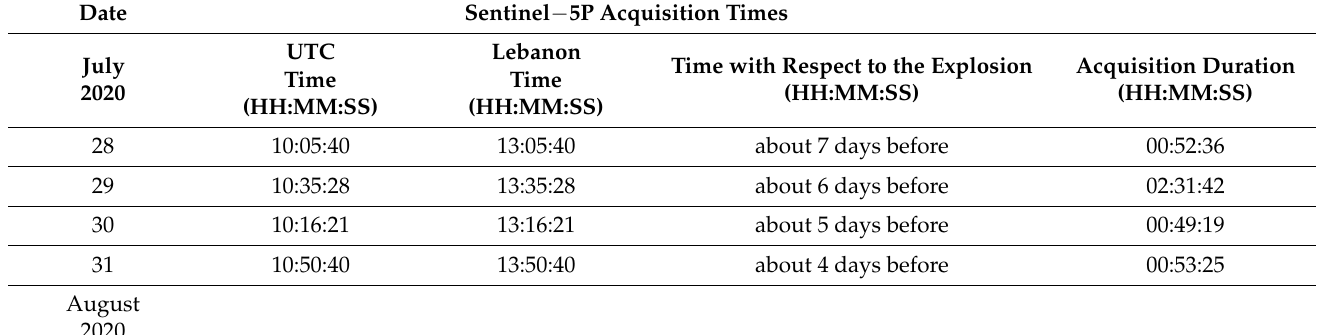
Table 3. Sentinel − 5P acquisition times over Beirut (28 July–8 August 2020). Sentinel − 5P Acquisition